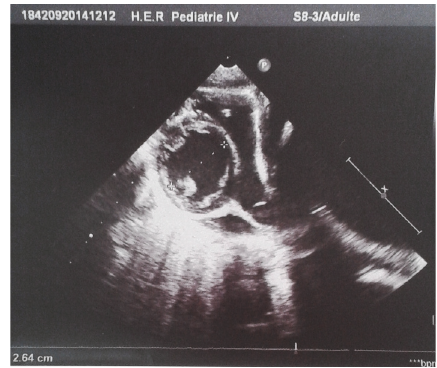
Figure 2: Echocardiography showing a 15 cm heart mass compressing the two